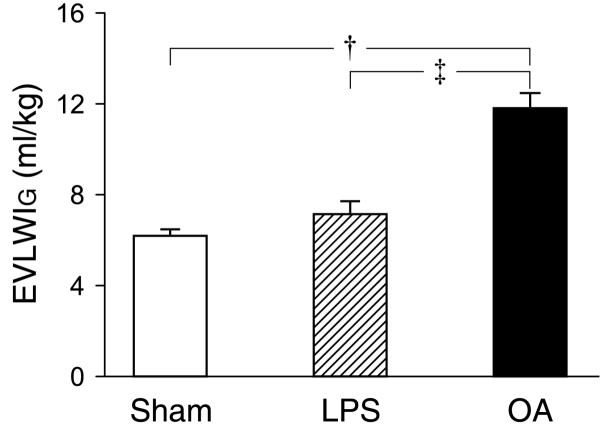
Gravimetric extravascular lung water index (EVLWIG) in sheep. Data are expressed as mean ± standard error of the mean. †P < 0.05, OA versus sham-operated group; ‡P < 0.05, LPS versus OA group. LPS = lipopolysaccharide; OA = oleic acid; Sham = sham-operated group.